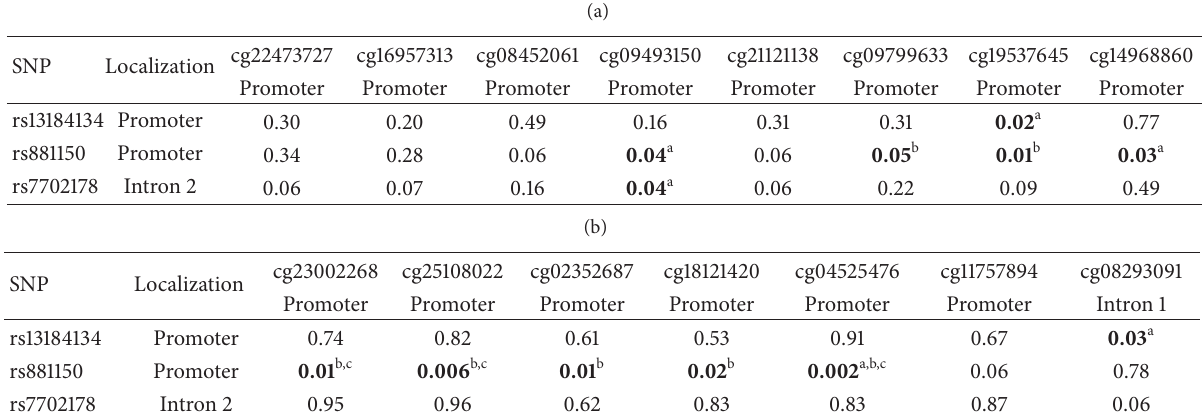
Table 5: Association of phenotype-associated SNPs with gene methylation levels. P values for significant associations and trends toward an association between relevant SNPs and CpG sites’ methylation are shown.